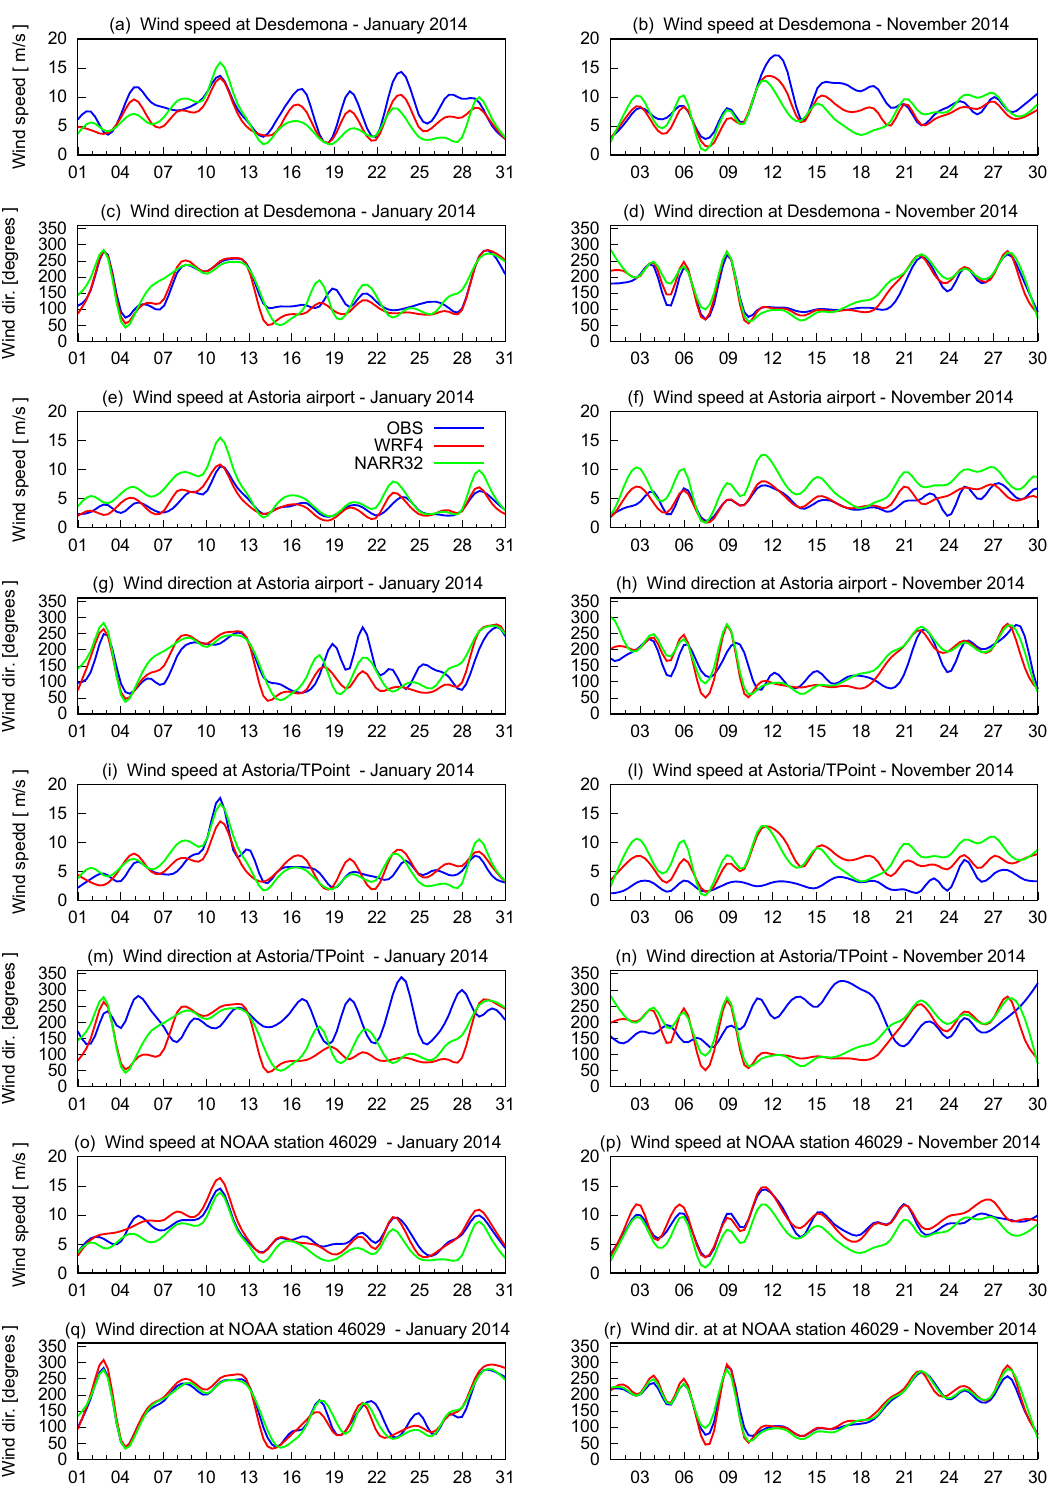
Figure A2. Time series of wind speed and direction at the three available stations in the estuary and at offshore NOAA station 46029, from observations, WRF4 and NARR32, in January and November 2014. ( a – d ) Desdemona; ( e – h ) Astoria airport; ( i – n ) Astoria/Tongue Point; ( o – r ) NOAA station 46029. The red and green lines refer to WRF4 and NARR32, respectively. The blue line refers to the observations.